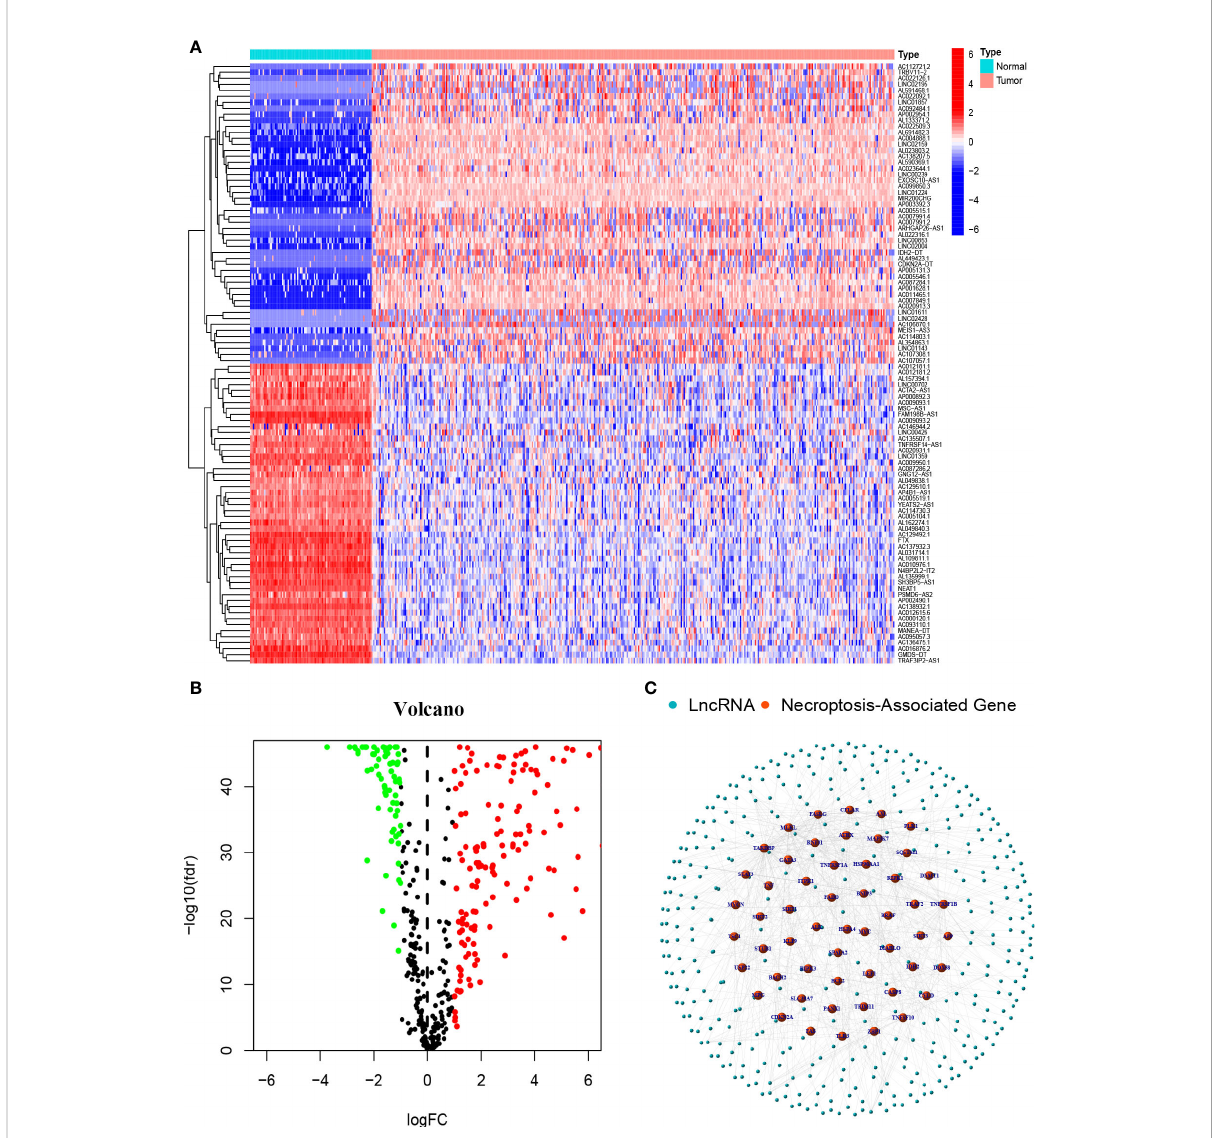
FIGURE 2 Necroptosis-associated Genes and lncRNAs screening in patients with OC (A) The heatmap of differentially expressed necroptosis-associated lncRNAs. (B) Volcano plot of 387 differentially expressed necroptosis-associated lncRNAs. (C) The network between necroptosis genes and lncRNAs (correlation coef fi cients>0.4 and